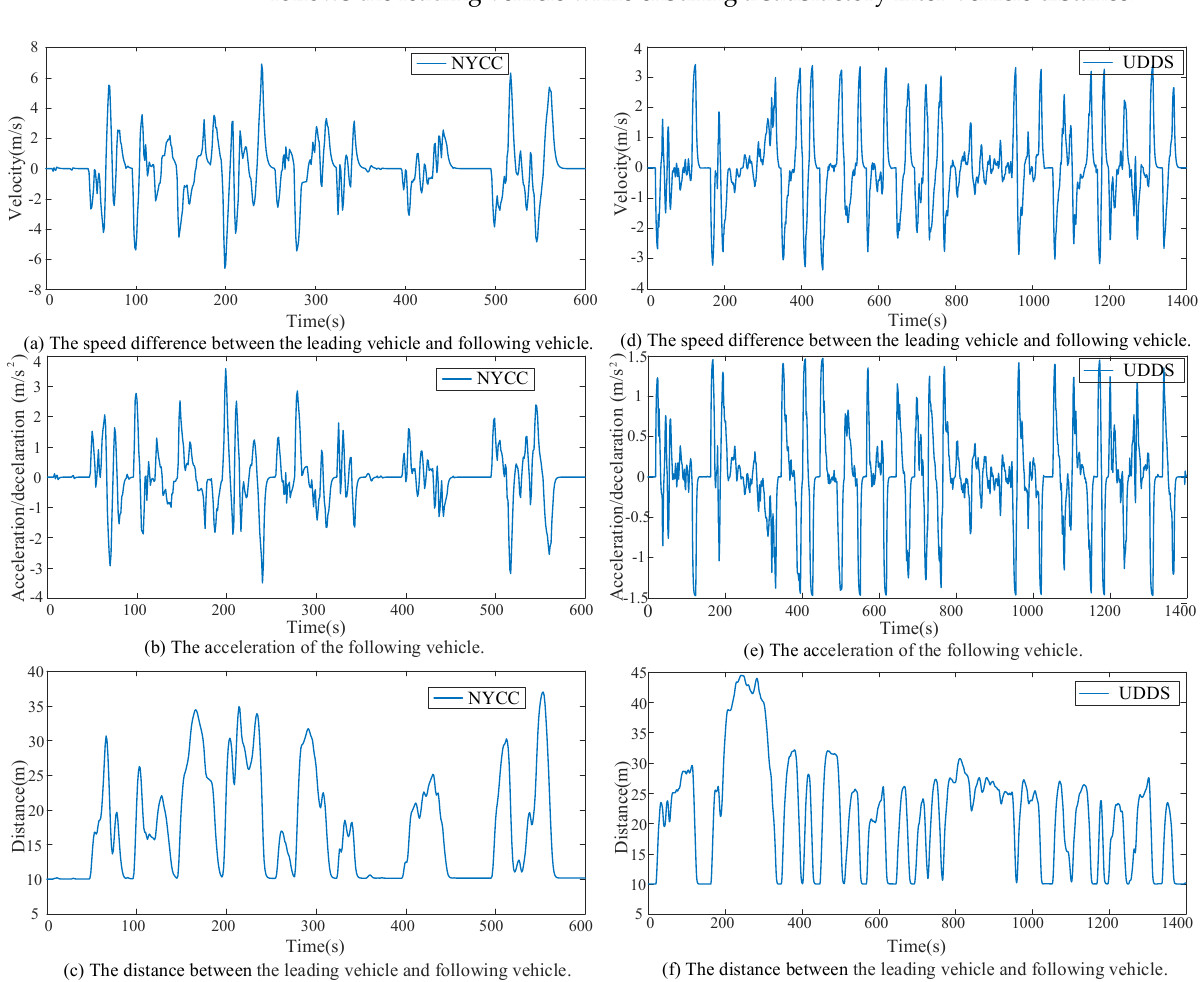
Figure 7. ( a – c ) The car-following results under the NYCC driving cycle. ( d – f ) The car-following results under the UDDS driving